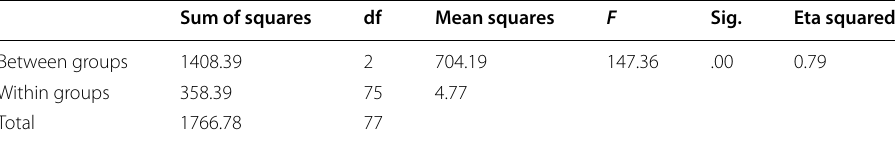
Table 4 Findings of one-way ANOVA: the participants’ posttest of speaking fluency scores Sum of squares df Mean squares F Sig. Eta squared Between groups